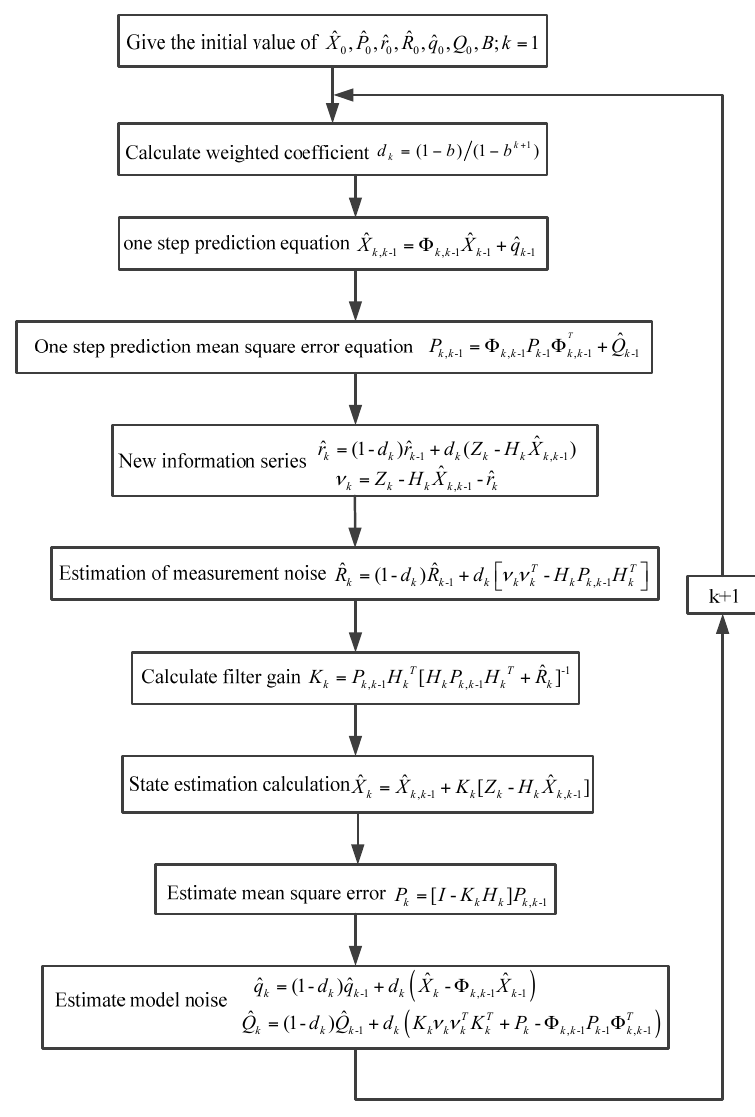
Figure 3. Flow chart of the SHAKF algorithm.